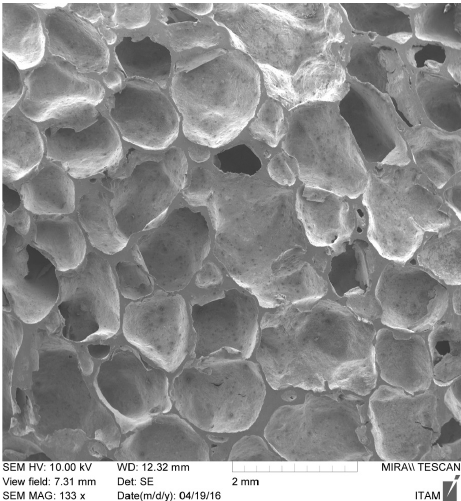
Figure 1. Inner structure of aluminium foam ob- tained by scanning electron microscopy.